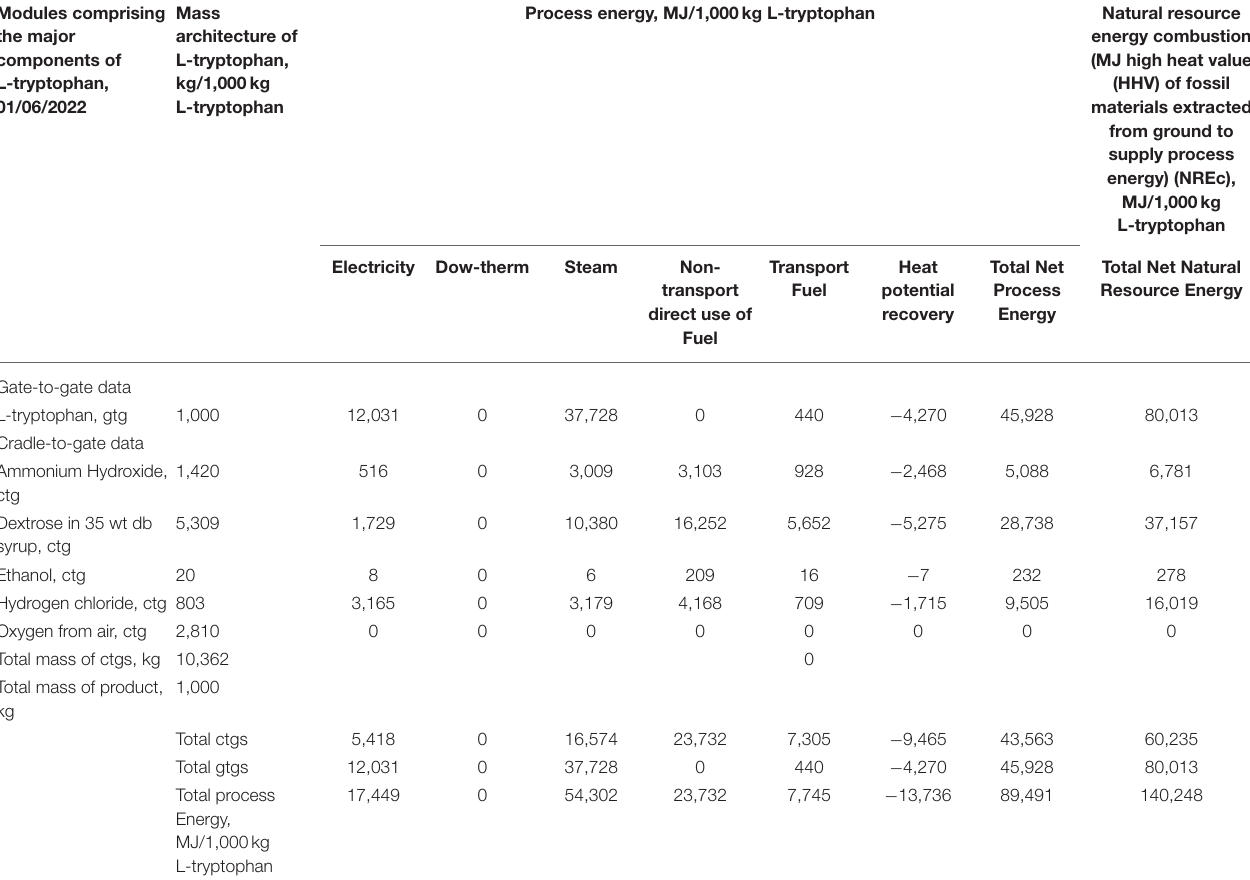
TABLE 2 | Process and natural resource energy combustion (NREc) for L-tryptophan cradle-to-gate (ctg). Modules comprising the major components of